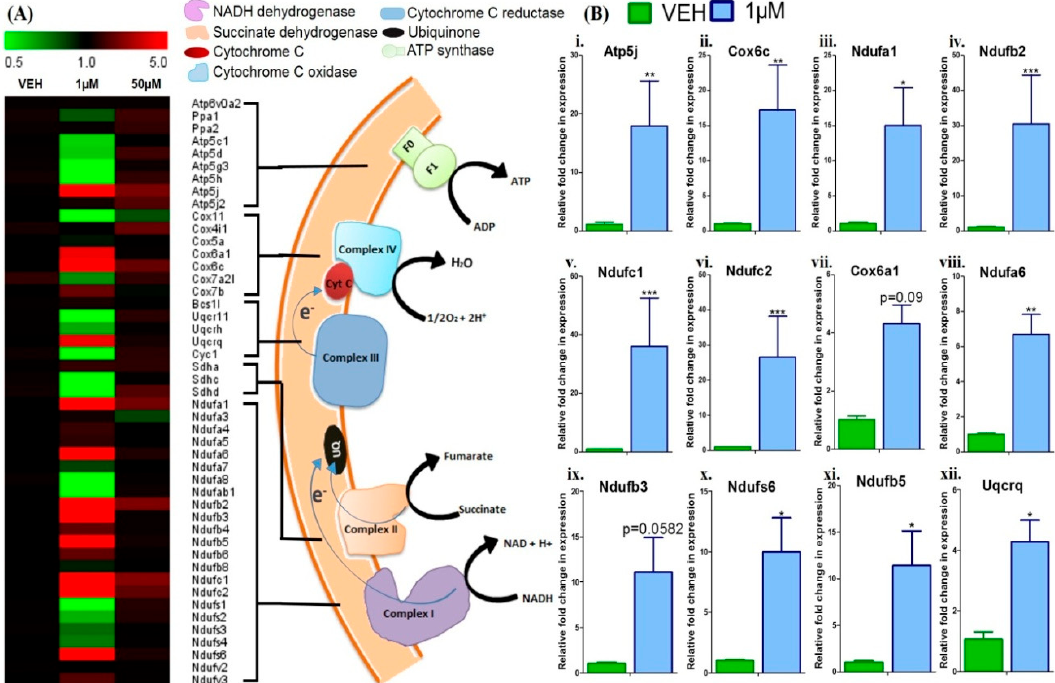
Figure 5. Heat map analysis of gene expression; and genes with statistically significant differential expression in 1 µM menthol treated group. ( A ) Heat map shows gene expression in vehicle, 1 µM and 50 µM menthol treated 3T3-L1 cells ( n = 3 each). Colour from red to green indicates high to low expression. ( B ) Comparative analysis of selected genes in 1 µM menthol treated group. Normalization was done with reference gene B2M ( β -2-microglobulin). The relative fold change in gene expression